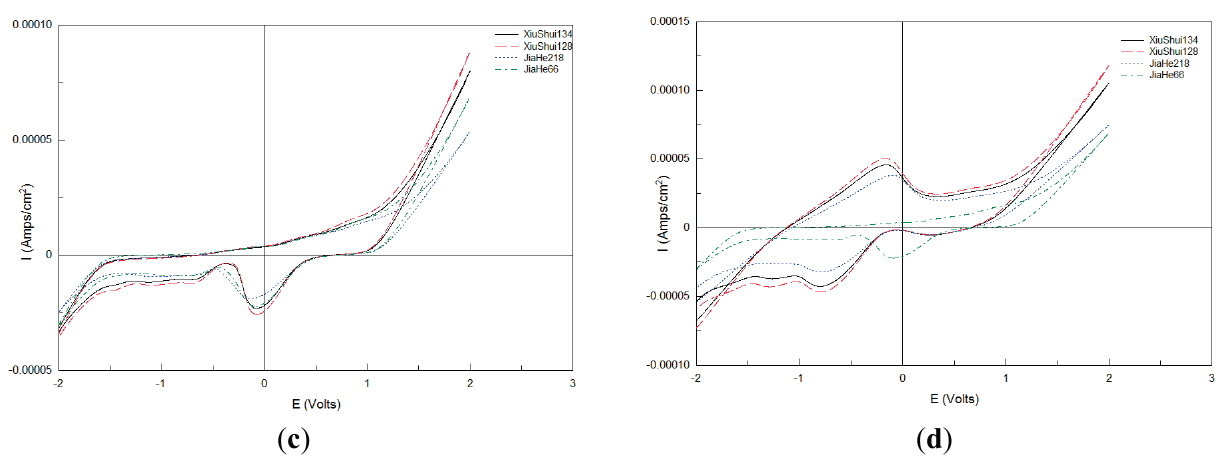
Figure 2. Voltammograms of four non-crushed rice sample solutions obtained using four electrodes. ( a ) Pt electrode; ( b ) Ag electrode; ( c ) Au electrode; ( d ) Pd